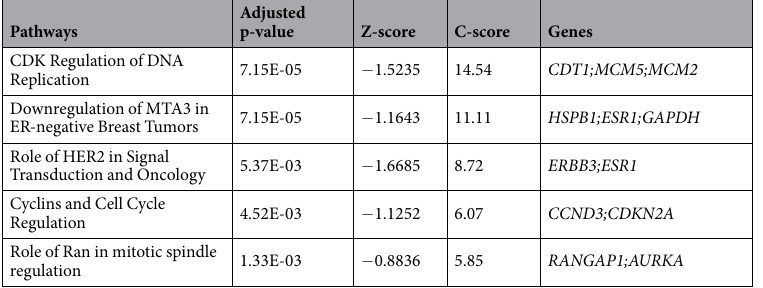
Table 2. Statistics of the top 5 pathways enriched by genes present in the integrated diagnostic network. Genes from the integrated diagnostic network and enriched in a given pathway are listed accordingly as ‘Genes’.